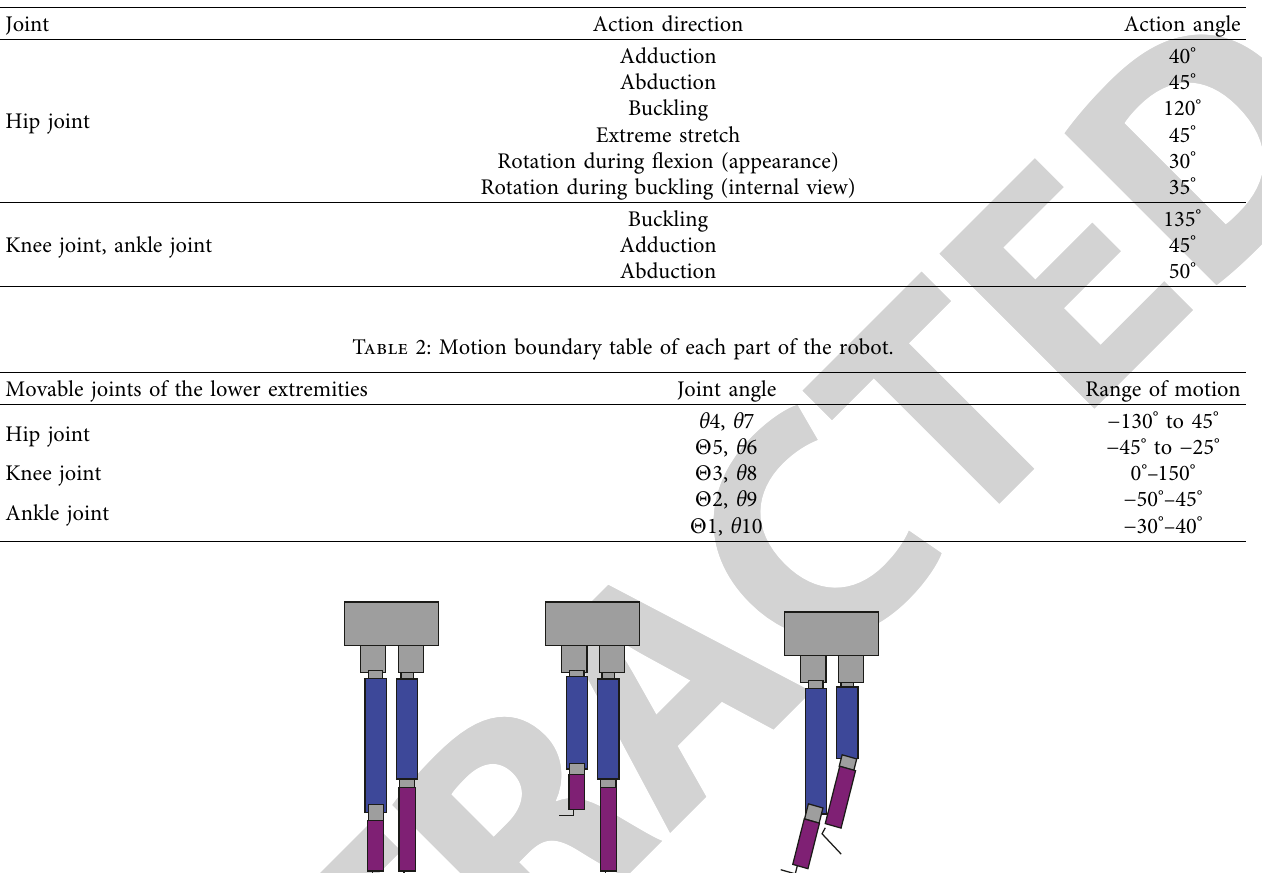
Figure 1: Abstract diagram of the dynamic mode of biped